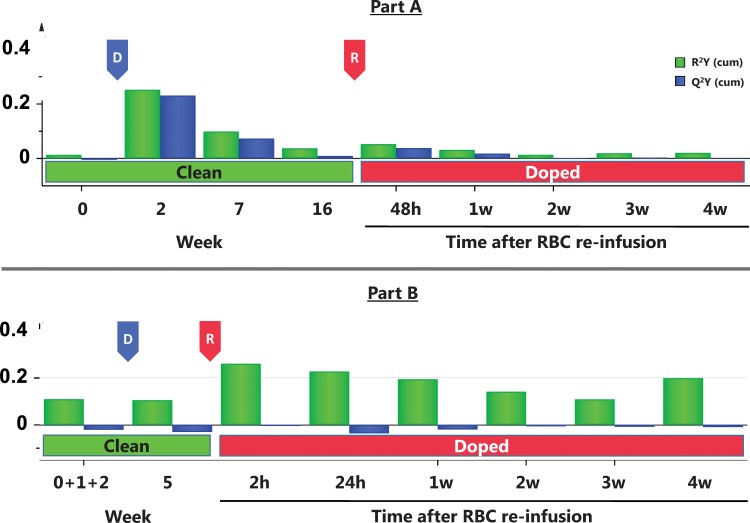
Part A of the Study and B. OPLS X/Y overview plot of the effect of blood donation and RBC re-infusion over time. The OPLS X/Y overview plot displays the individual cumulative Regression (R2) and Prediction (Q2) for every time point of blood sampling in Part A of the Study and B. Part A of the Study: R2X = 0.60; Q2 = 0.04. Part B of the Study: R2X = 0.49; Q2 = -0.01. Neither part (A and B) of the study reached a significant separation of Clean and Doped subjects based on hematological variables. D; Blood donation, R; RBC re-infusion.